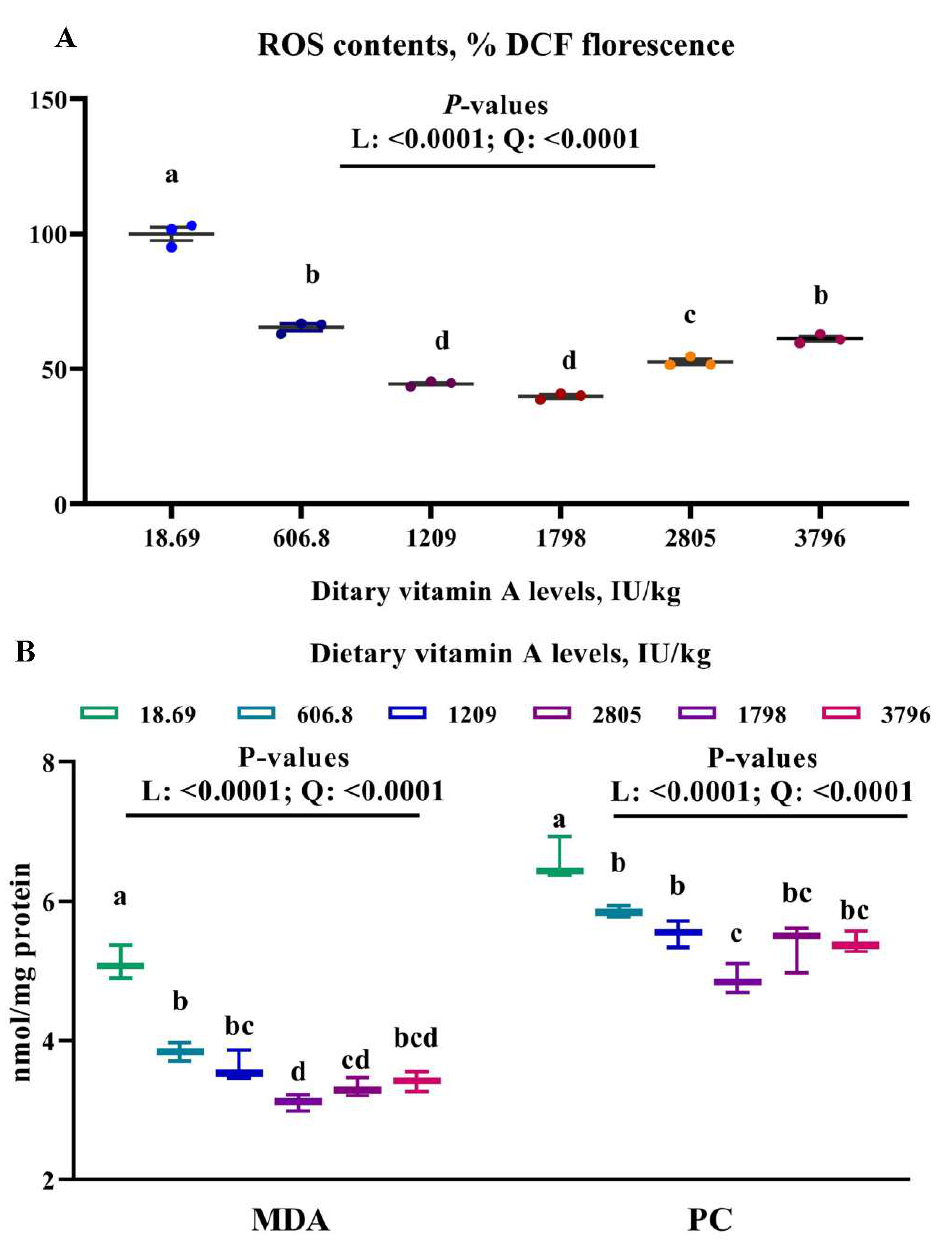
Figure 2. Effects of dietary vitamin A on contents of ROS ( A ), MDA and PC ( B ) in muscle of on- growing grass carp. Data are means ± SEM of three replicate groups, two fish for each replicate ( n = 3). a,b,c,d within a column, means without a common lowercase superscript differ ( p < 0.05). p -values underlined with a solid line indicate a linear and quadratic response to dietary vitamin A levels. SEM = standard error of the mean; L = linear; Q = quadratic; ROS = reactive oxygen species, %DCF florescence; MDA = malondialdehyde, nmol/mg prot; PC = protein carbonyl, nmol/mg prot. Table 6. Effect of dietary vitamin A on antioxidant parameters in muscle of on-growing grass carp